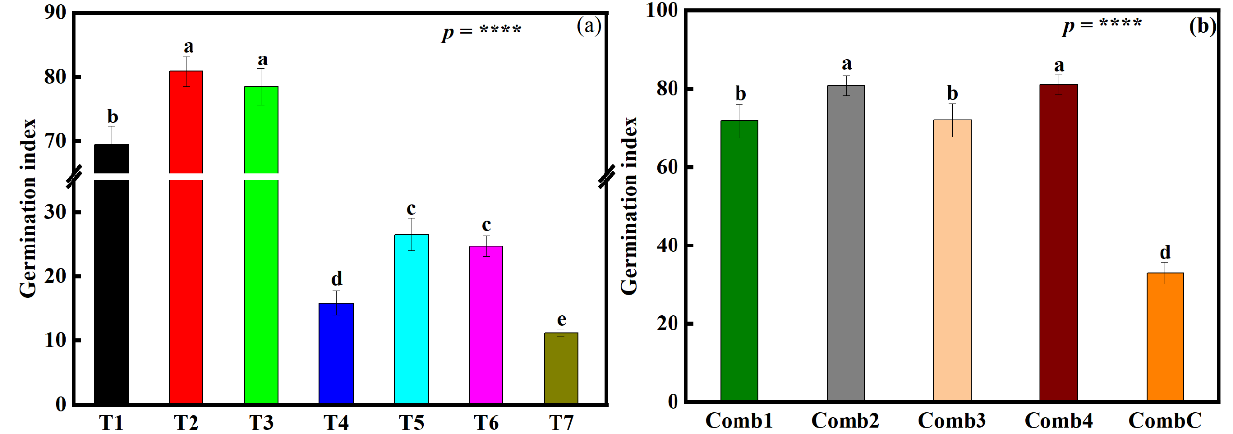
Figure 2. Influence of the different fertilizer treatments on rice seed germination index (SGI) of ( a ) rice seeds sown under the small-scale plot experiment and ( b ) rice seeds sown under the large-scale field experiment. Data (means ± SE, n = 5) followed by different subscripts denotes significant differences between treatments at p < 0.05 according to Tukey’s HSD. p -values of one-way ANOVA, are indicated: p < 0.0001, ****. Treatments for ( a ): sepiolite (Mg 4 Si 6 O 15 (OH) 2 • 6(H 2 O)), 1.27 kg m − 2 (T1); sodium metasilicate (Na 2 SiO 3 ), 0.03 kg m − 2 (T2); humic acid, 0.07 kg m − 2 (T3); calcium magnesium phosphate fertilizer, 0.09 kg m − 2 (T4); ferrous sulfate (FeSO 4 ), 0.07 kg m − 2 + manganese sulfate (MgSO 4 ), 0.007 kg m − 2 (T5); 6) straw biochar, 0.75 kg m − 2 (T6); and the control treatment (no